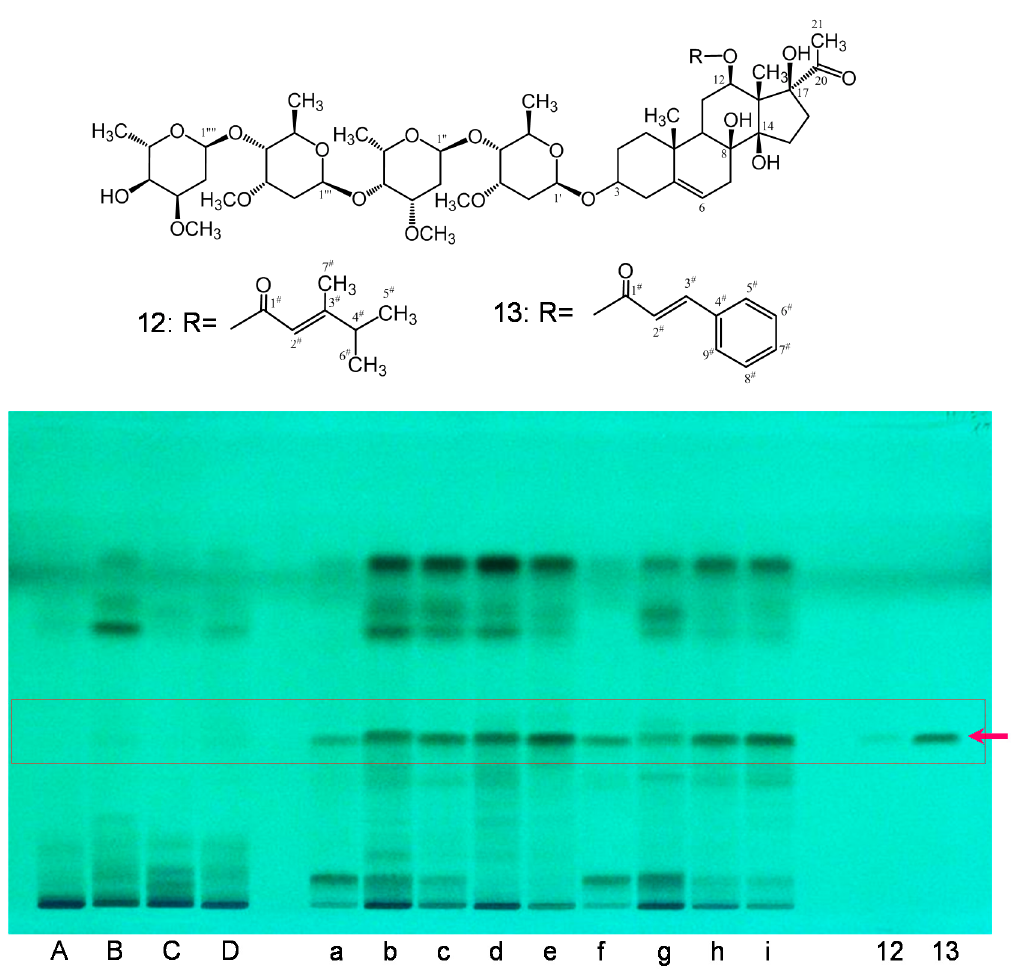
Figure 6. TLC chromatograms of the crude drugs Cynanchi Wilfordii Radix (CWR) ( A – D ) and Cynanchi Auriculati Radix (CAR) ( a – i ). TLC plate illuminated with UV 254 nm. 12: wilfoside C1N, 13: wilfoside K1N. Conditions are described in Section 3.